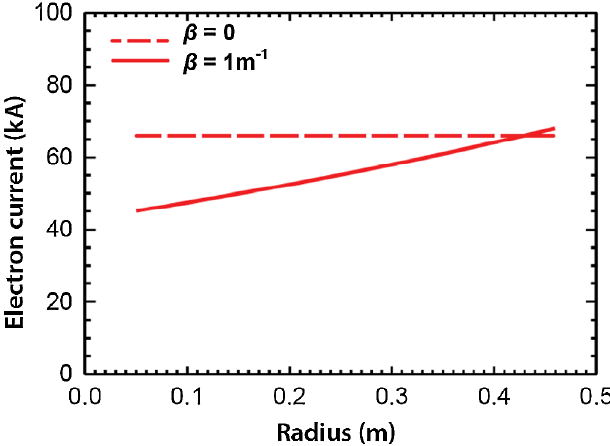
FIG. 3. (Color) Magnitude of the analytically calculated electron flow current as a function of radius for a radial disk MITL, plotted for 0 : 05 m (cid:9) r (cid:9) 0 : 46 m . The inductance of the load is 51.2 nH; the maximum gap spacing is 32.6 mm and is located at the edge of the anode disk ( r ¼ 0 : 46 m ). The upper curve represents the constant electron flow profile resulting from an insulated line where electrons are not returned to the cathode surface. The lower curve represents a positive retrapping rate where the magnitude of the current is attenuated by a factor of 1 =e with every meter towards the load from the power inlet. The total anode current at this time is approximately 1.5